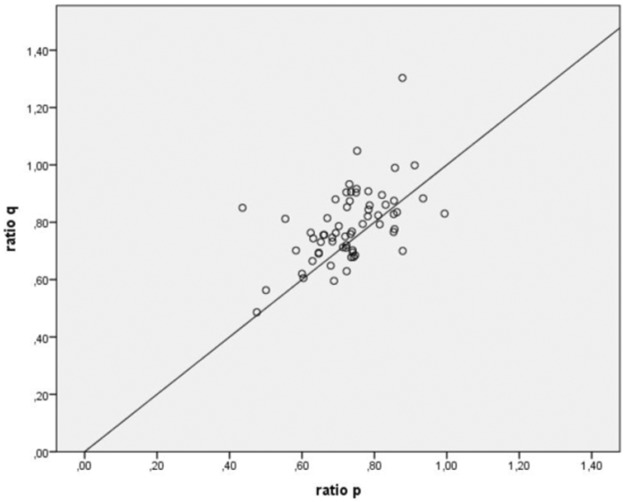
Ratios of isotropic components (p) versus anisotropic components (q) of the diffusion tensor.The ratios of isotropic components (p) are plotted against the anisotropic components (q) of the diffusion tensor.